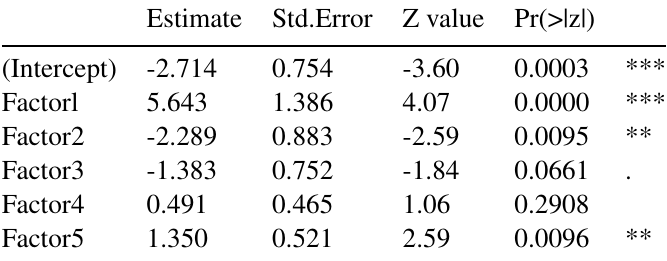
Table 4 Estimation results of random effect model.